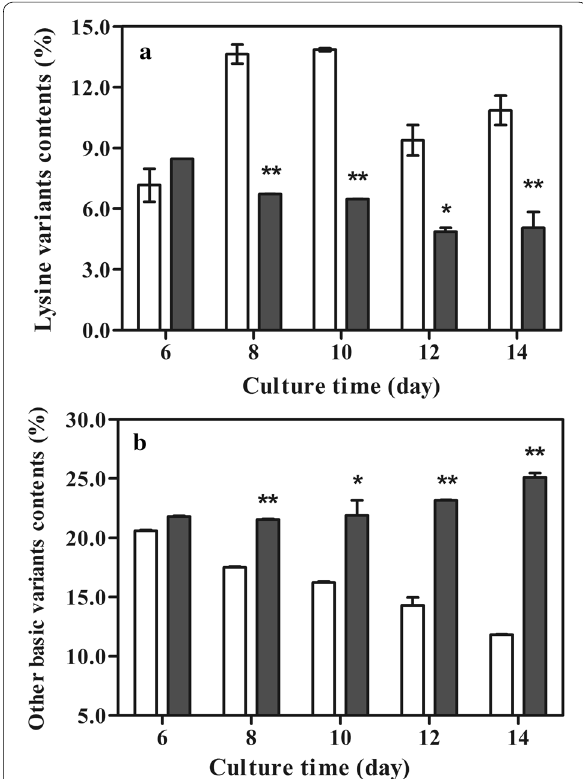
Fig. 5 Profiles of mAb lysine variant level and other basic variant level in different feed medium. a Lysine variant level; b other basic variant. (White bar) control condition; (shaded bar) uridine added condition. Other basic variant was detected with carboxypeptidase B treatment; lysine variant level was quantified by comparing the basic variant levels obtained from WCX with or without carboxypeptidase B treatment. The error bars indicate the standard deviations from three independent experiments and p ‑values were estimated by